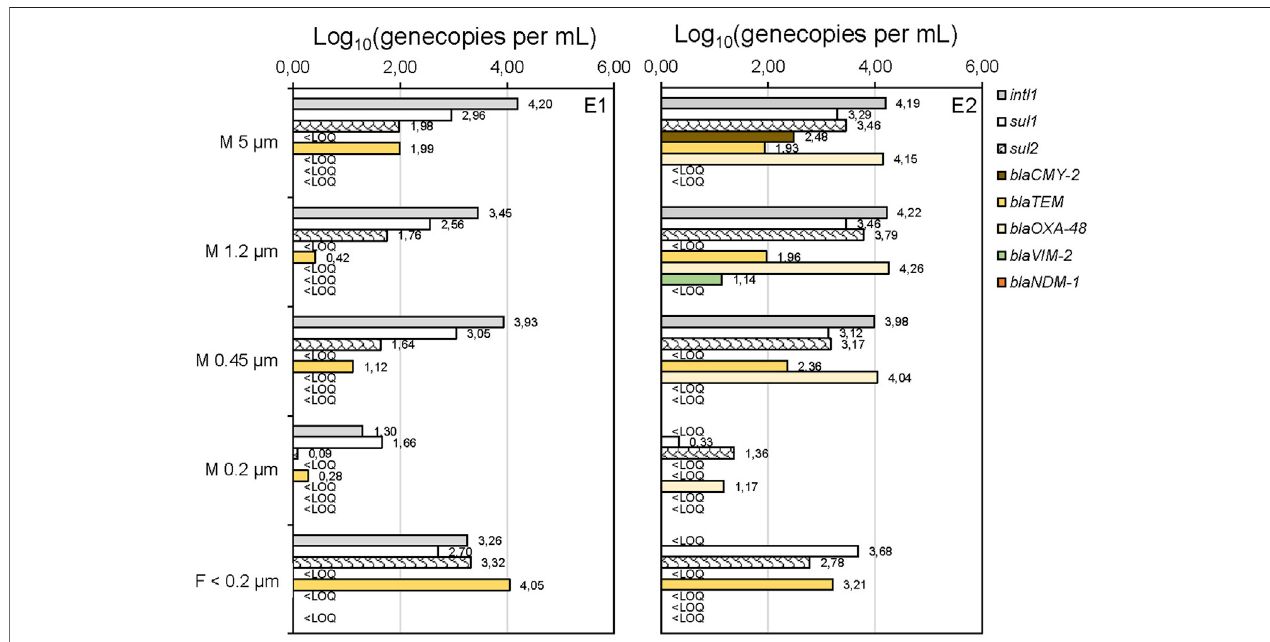
FIGURE 1 | Application of cascade fi ltration on surface-water samples (river Alz, Germany, May (E1) and August (E2) 2021) and analysis of gene copies (GC)/mL after DNA extraction from the membrane (M 5 – 0.2 µm) and without DNA extraction in the fi ltrate < 0.2 µm. Limit of quanti fi cation (LOQ) was about 1 gene copy per mL.